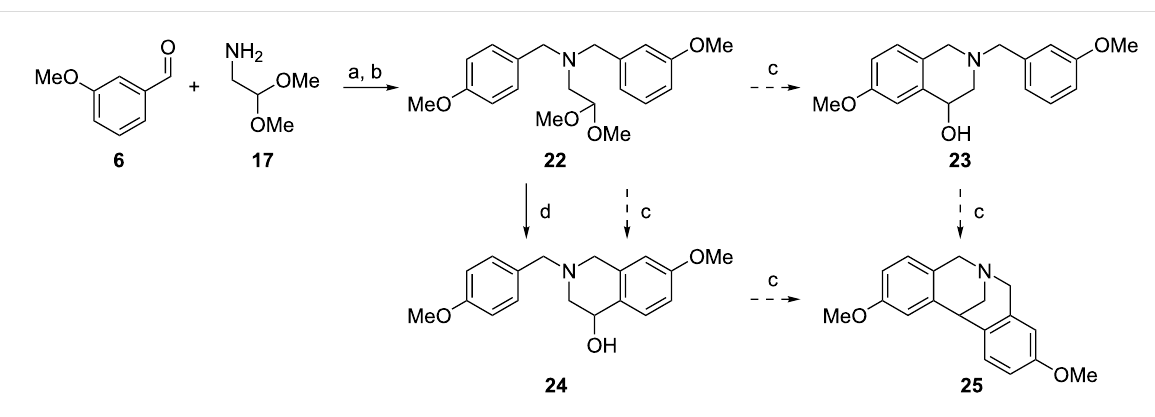
Scheme 8: Competition between ring formation para - or meta - to an activating group. Conditions: (a) NaBH(OAc) 3 , CHCl 3 , rt; (b) 4-methoxybenzalde- hyde,